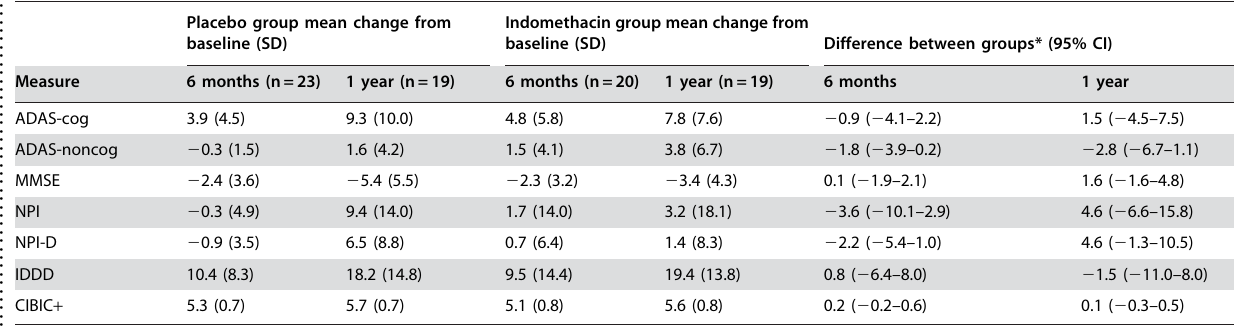
Table 2. Mean change from baseline of outcome measures, and difference in scores between the placebo and indomethacin group, after six months and one year of treatment. .. ... .... ... ... .... ... ... .... ... ... .... ... ... .... ... ... .... ... ... .... ... ... .... ... ... .... ... ... .... ... ... .... ... ... .... ... ... .... ... ... .... ... ... . Indomethacin group mean change from Placebo group mean change from baseline (SD) baseline (SD) Difference between groups* (95% CI) Measure